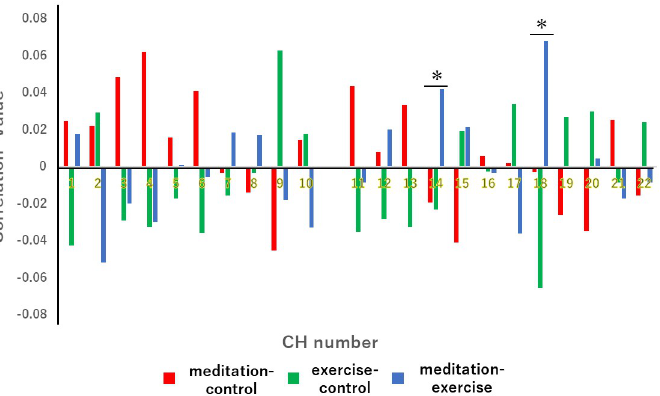
Fig 6. Coefficient correlations of FFT-analyzed NIRS frequencies at each channel among the meditation-control pair (red), the exercise-control pair (green), and the meditation-exercise pair (blue) analyses. The CH14 and CH18 showed significant differences only in the meditation-exercise pair (blue). One-way analysis of variance (ANOVA) followed by a post-hoc Tukey test was performed. For CH14, F (2,48) = 3.407, � p < 0.05; for CH18, F (2,48) = 3.207, � p <